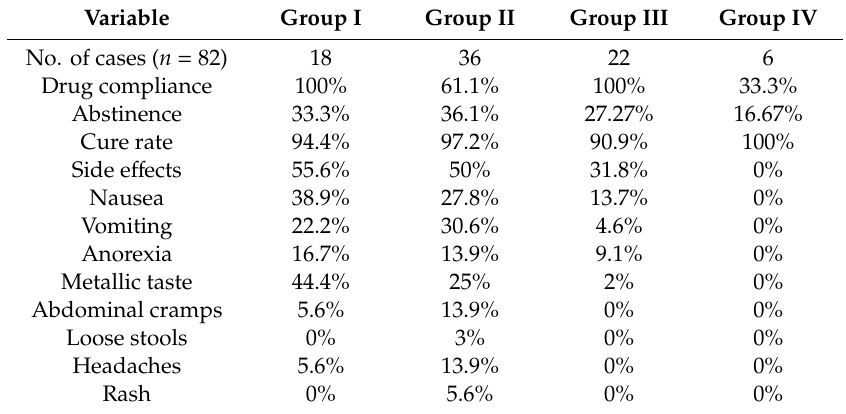
Table 2. Comparison of di ff erent treatment options for trichomoniasis which were treated.